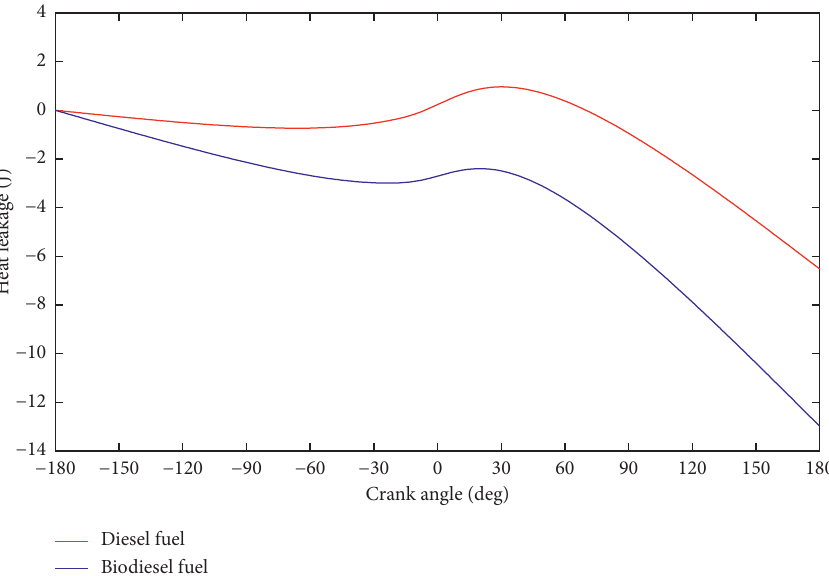
Figure 5: Heat leakage comparison of biodiesel and diesel fuels.